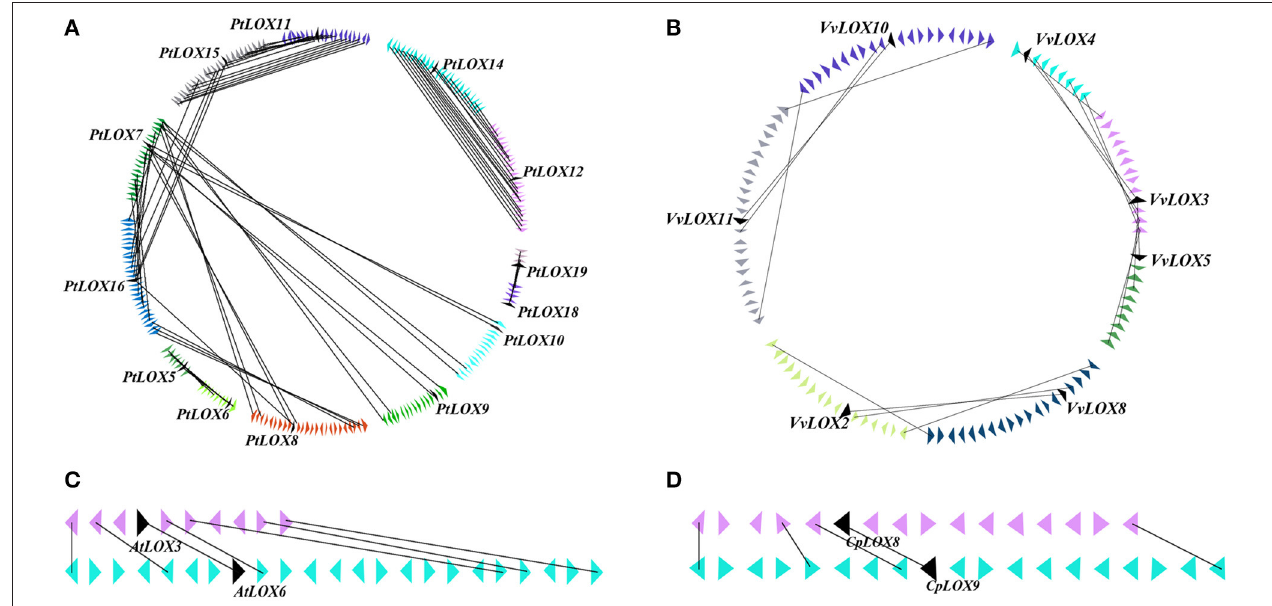
FIGURE 4 | Microsynteny related to LOX families in (A) Populus (B) Vitis (C) Arabidopsis (D) Carica . The genomic fragment is represented by a series of triangles that represent a gene in a family and its flanking genes. The genes in the same fragment show the same color except the gene in a family which is shaded by black triangle. The triangle also indicates the gene’s orientation on strands. The homologous genes on two fragments are connected by a gray line.